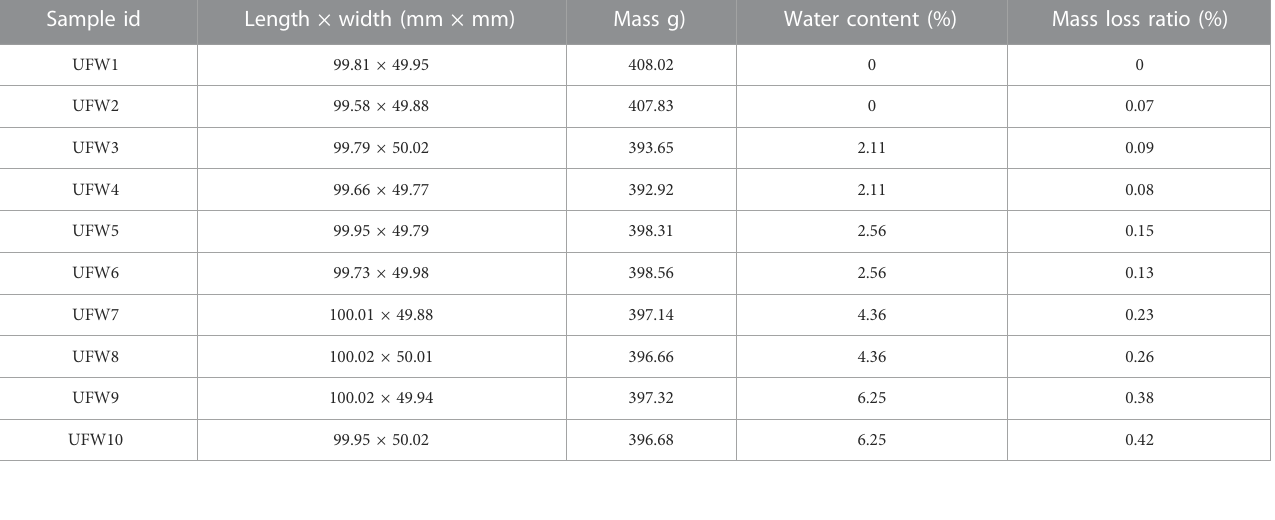
TABLE 1 Description of the basic physical state and loading conditions for the samples.